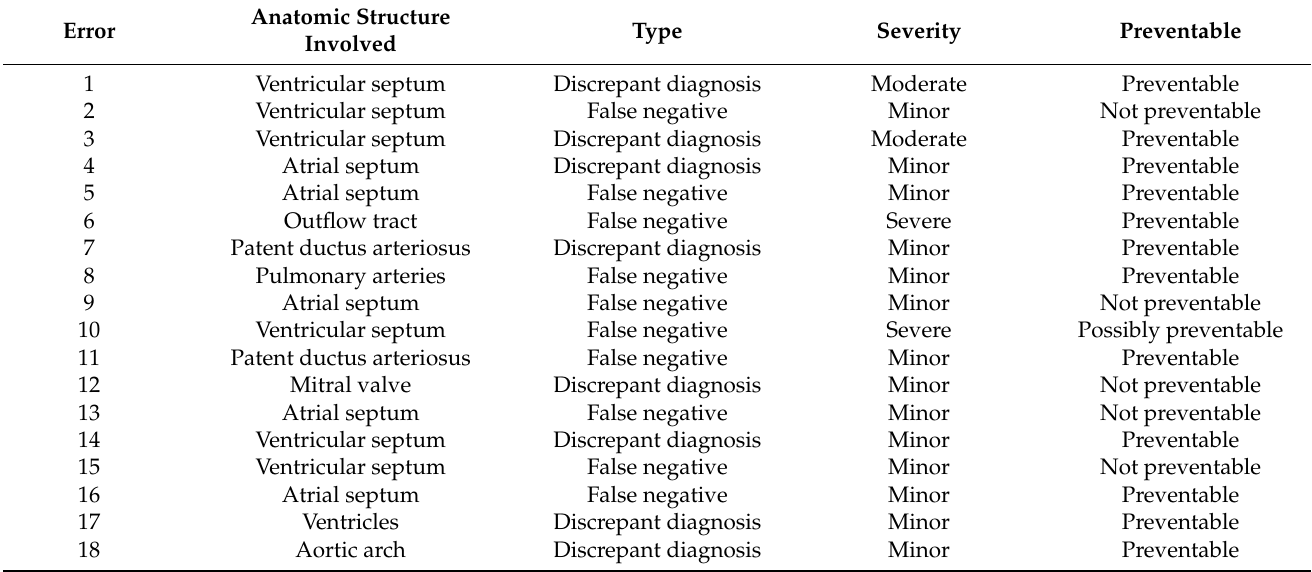
Table 1. Diagnostic errors identified in the baseline